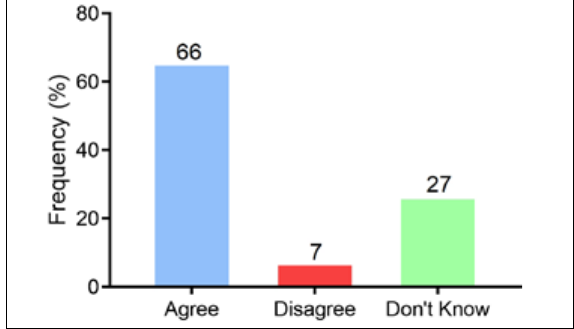
Figure 6. Frequency histogram for response to Question 1: ‘In Australia, a general dentist who performs orthodontic treatment (e.g. braces, Invisalign®) must also be a specialist orthodontist’.